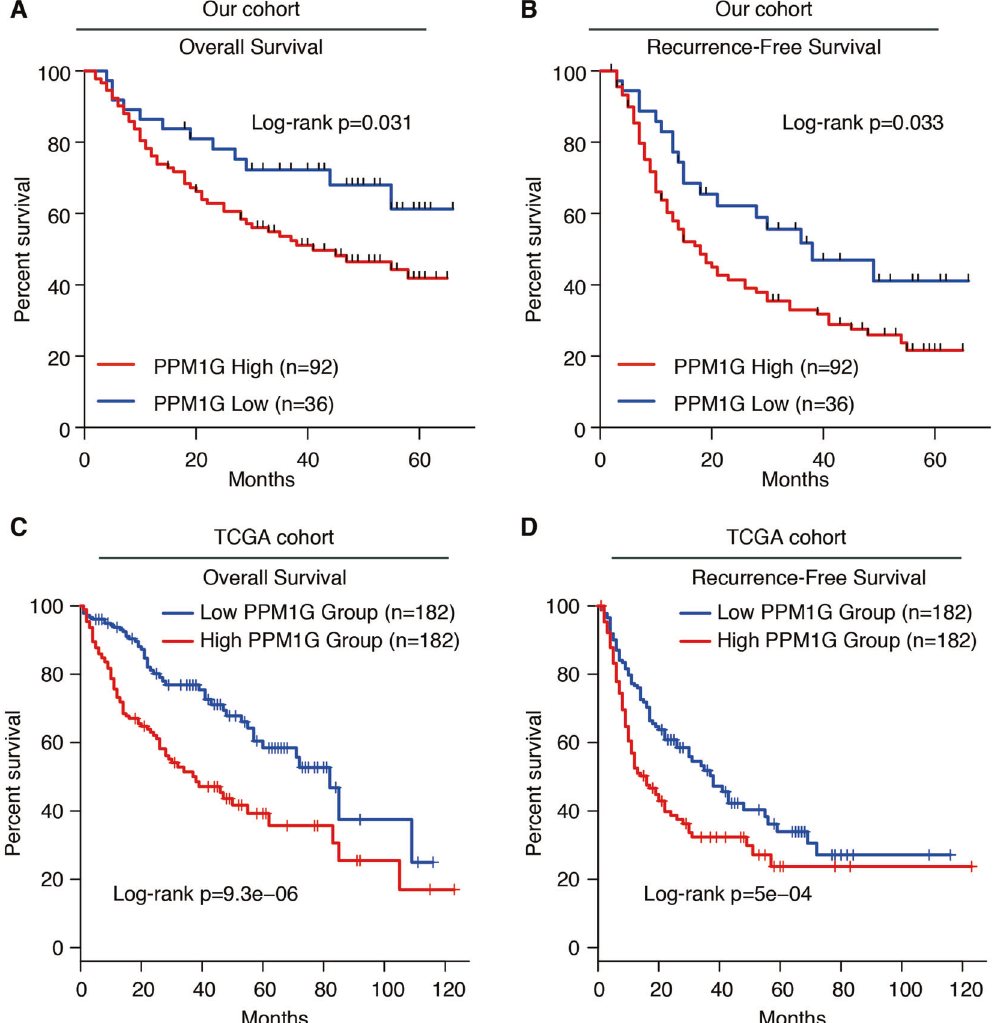
Fig. 2 High levels of PPM1G were related to the poor prognosis of HCC. A Kaplan – Meier analysis of the overall survival in PPM1G-high and PPM1G-low groups of our HCC cohort. B Kaplan – Meier analysis of the recurrence-free survival in PPM1G-high and PPM1G-low groups of our HCC cohort. The expression of PPM1G was divided into two groups according to the PPM1G score. C Kaplan – Meier analysis of the overall survival in PPM1G-high and PPM1G-low groups of the TCGA-LIHC cohort. D Kaplan – Meier analysis of the recurrence-free survival in PPM1G- high and PPM1G-low groups of the TCGA-LIHC cohort. The expression of PPM1G was divided into two groups according to the PPM1G mRNA